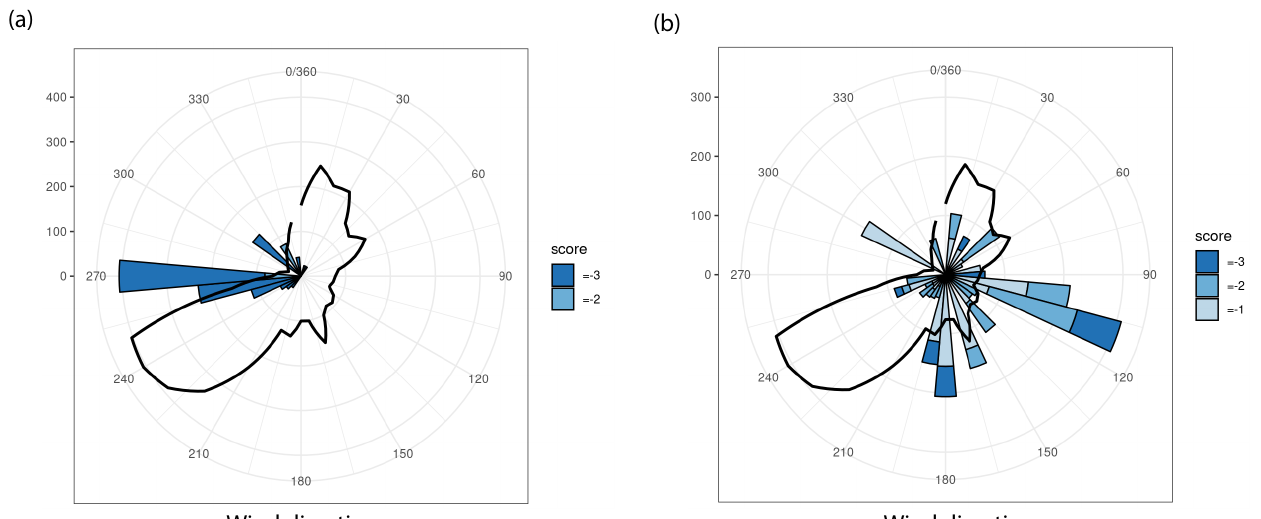
Figure 9. Examples of wind rose diagrams presenting the number of odour annoyance reports per wind sector, normalised for the frequency distribution. The black line represents the wind direction frequency distribution. The score ( − 1, − 2 and − 3) indicates the degree of unpleasantness of the odour experienced by the person who made the report (the more negative the value, the more unpleasant the